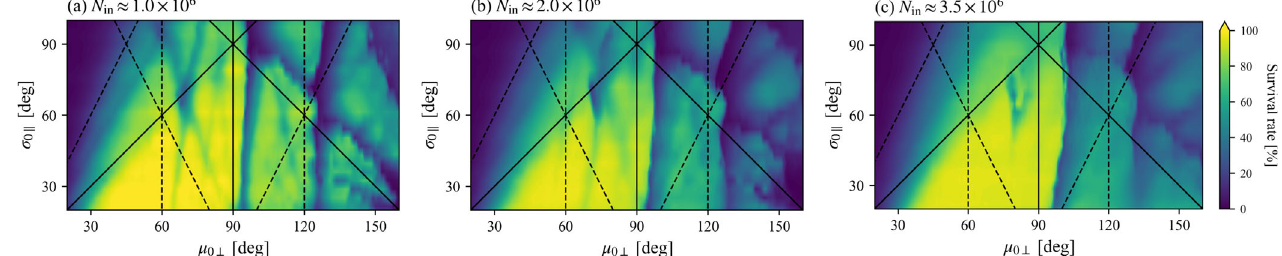
FIG. 7. Stability tune diagram for the ion storage period of 10 ms (10000 AG cells). The number of ions confined initially in the LPT is adjusted to about (a) 1 . 0 × 10 6 , (b) 2 . 0 × 10 6 , and (c) 3 . 5 × 10 6